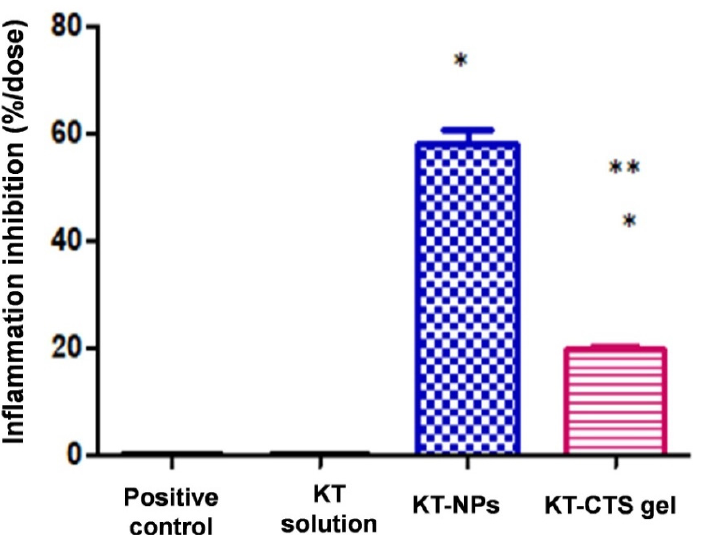
Figure 8. Anti-inflammatory efficacy of studied formulations expressed as a percentage reduction in in-flammation when compared to a control. The results are presented as the mean ± SD of three measurements. * stands for statistical differences between the formulations and the positive control and the KT solution, ** stands for statistical differences between KT-NPs and KT-CTS gel (p < 0.0001).